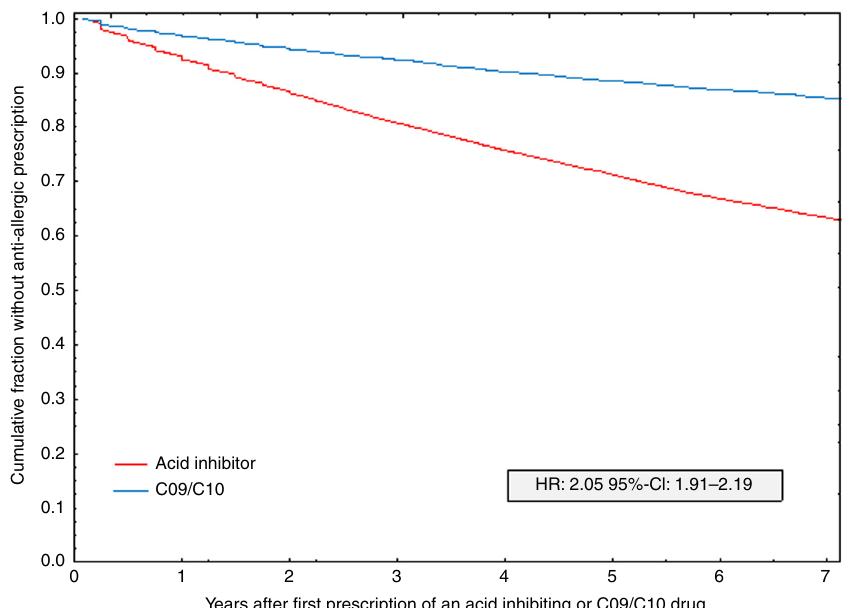
Fig. 3 Anti-allergic medication following treatment with acid-inhibiting drugs and controls. Kaplan – Meier plots of the cumulative proportion without subsequent fi rst anti-allergic medication for those with an acid-inhibiting drug prescription and the contrast group of those with an anti-hypertensive or lipid-modifying drug (C09/C10) prescription